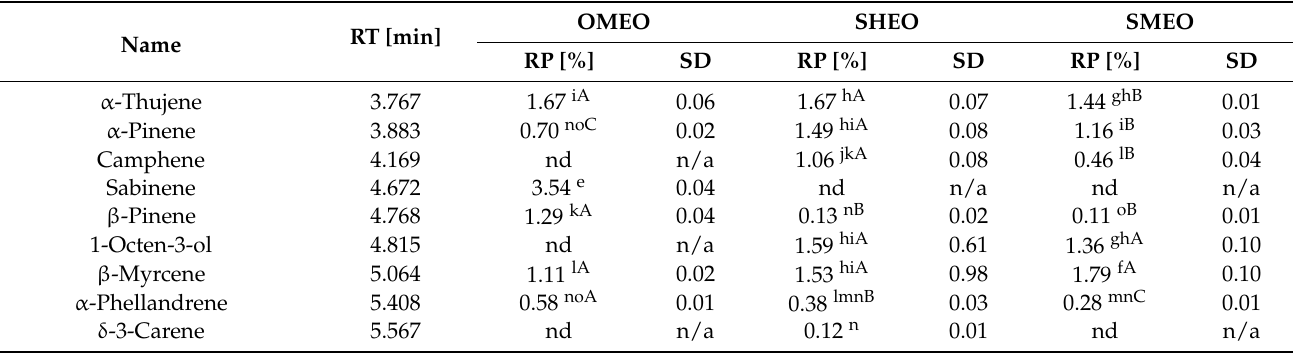
Table 1. Chemical profile of selected essential